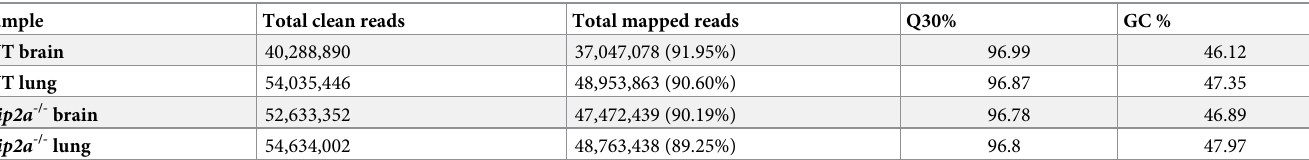
Table 1. Statistics of sequence